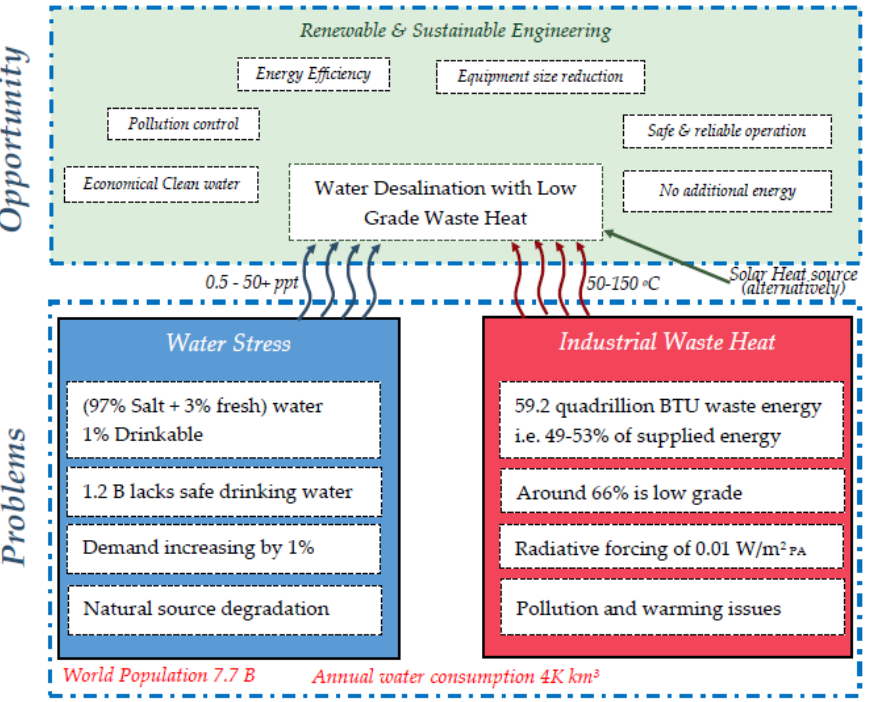
Figure 1. Problem driven opportunity for water treatment [5–9].